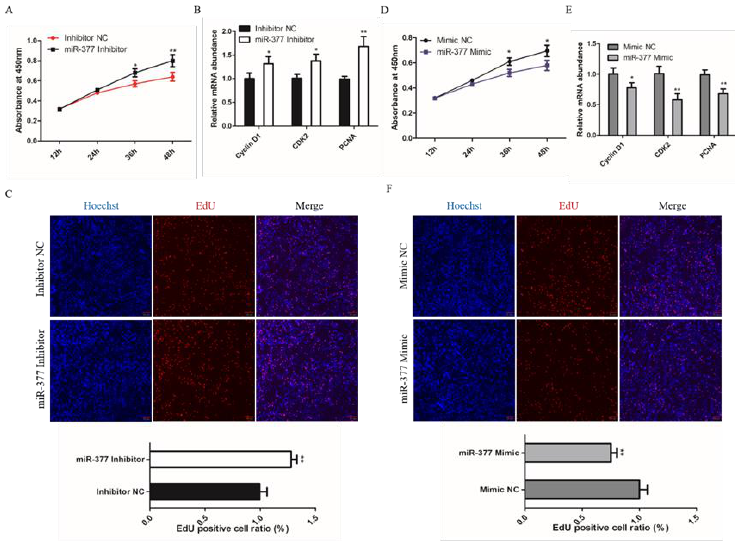
Figure 2. Effect of miR-377 on the proliferation of bovine SMSCs. ( A ) CCK8 analysis equal numbers of bovine SMSCs transfected with inhibitor NC and miR-377 inhibitor in GM for 12, 24, 36 and 48 h. The absorbance at 450 nm on the Y-axis indicates the number of viable cells. ( B ) qPCR analysis the expression levels of CyclinD1, CDK2 and PCNA in inhibitor NC and miR-377 inhibitor cells. ( C ) EdU staining of bovine SMSCs after transfected with inhibitor NC and miR-377 inhibitor. The lower histogram represents the proliferation rate. ( D ) CCK8 analysis equal numbers of bovine SMSCs transfected with Mimic NC and miR-377 Mimic in GM for 12, 24, 36 and 48 h. The absorbance at 450 nm on the Y-axis indicates the number of viable cells. ( E ) qPCR analysis the expression levels of CyclinD1, CDK2 and PCNA in Mimic NC and miR-377 Mimic cells. ( F ) EdU staining of bovine SMSCs after transfected with Mimic NC and miR-377 Mimic. The lower histogram represents the proliferation rate. Data are expressed as mean ± SEM ( n = 3). * p < 0.05; ** p < 0.01.